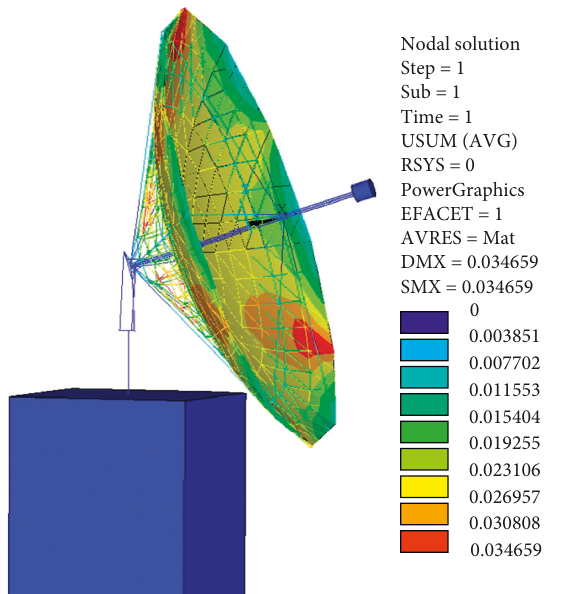
Figure 23: Deformation of the SSPCI at a limit orientation under the temperature load of 100 ° C.